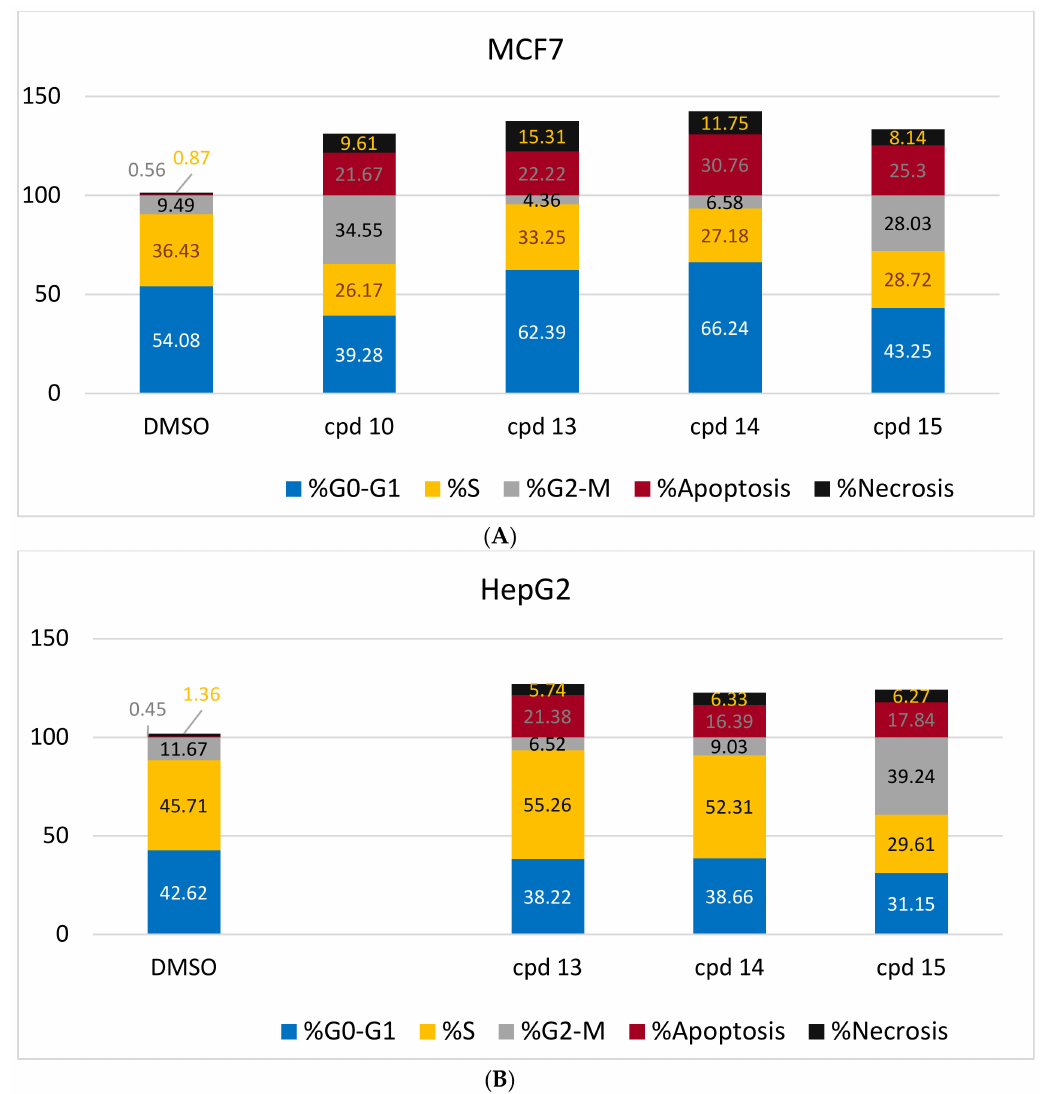
Figure 4. Graphical representations of the cell cycle distributions of MCF-7 ( A ) and HepG2 ( B ) under untreated control conditions (DMSO) and in response to the IC 50 treatment of compounds 10 or 13 – 15 for 48 h. The detailed analysis is given in Table